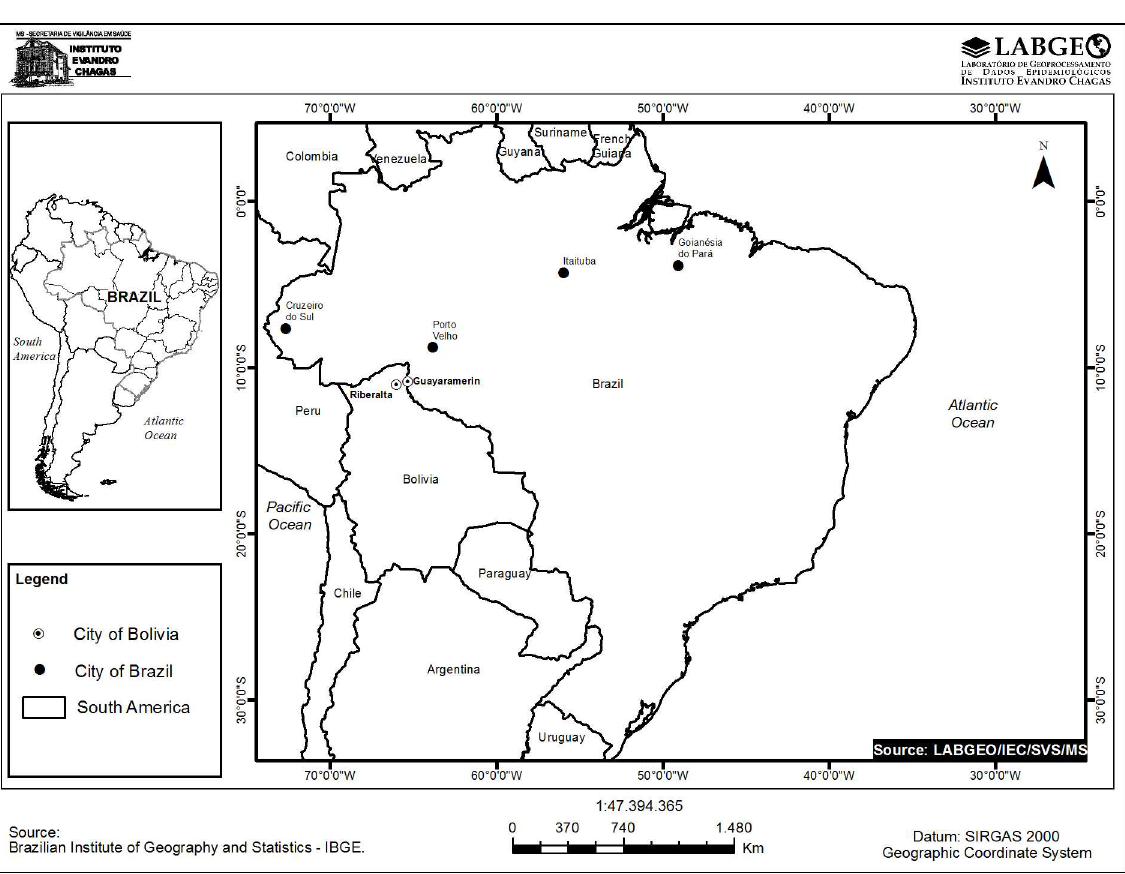
Fig 1. Study sites. Locationsof study sites from Brazil and Bolivia are